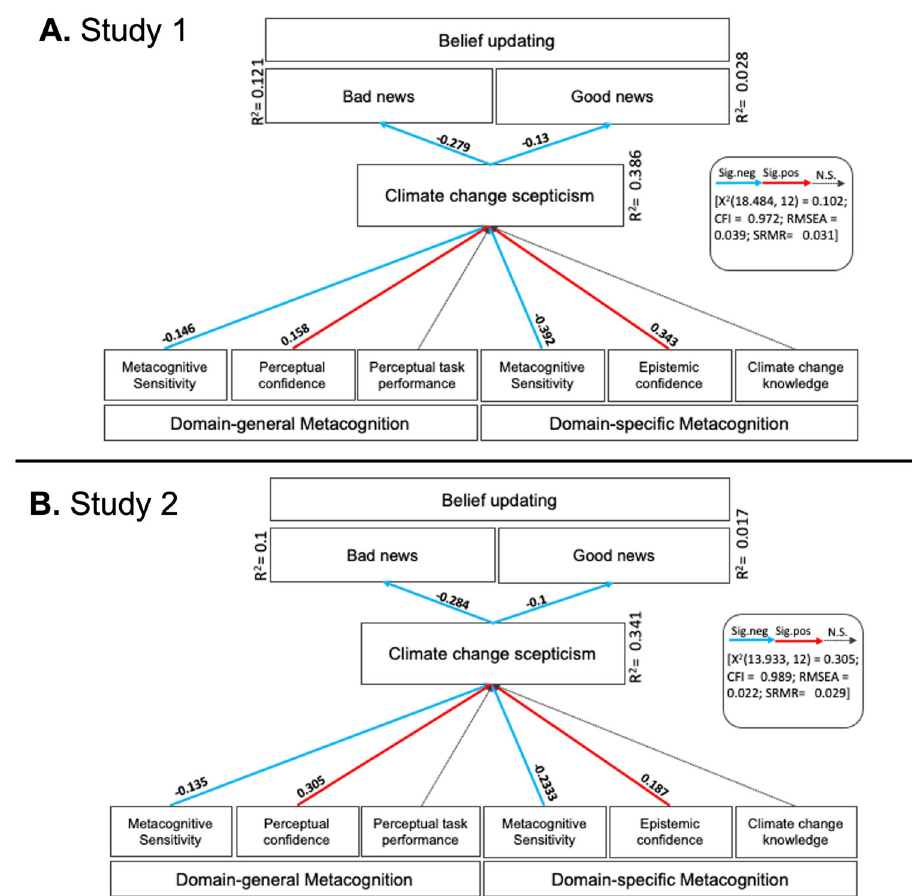
Fig. 3 Path analysis for Studies 1 and 2. Path analysis depicting how metacognitive abilities impact attitudes and the updating of climate change related beliefs in Study 1 (panel A ) and Study 2 (panel B ). For both fi gures, signi fi cance level was <0.05. N.S., not signi fi cant; Sig. Neg., signi fi cant negative pathway; Sig. Pos., signi fi cant positive